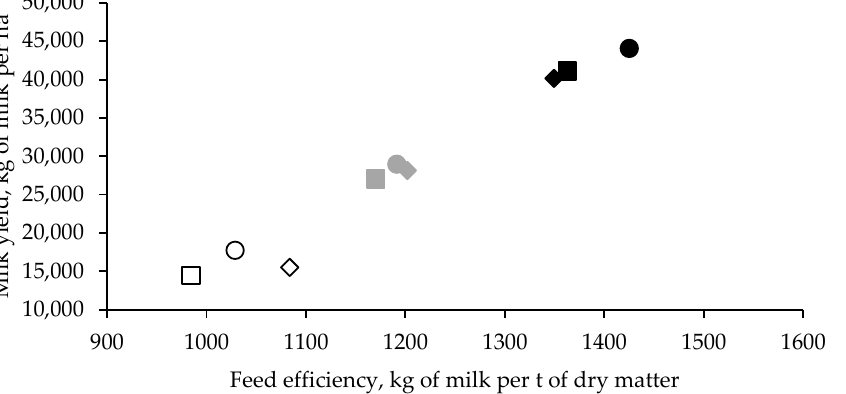
Figure 1. Estimation of milk production through Milk 2006 of the Maximus (●); Defender ( ■ ); and Feroz ( ♦ ) hybrids in three harvest stages: R4 (white); R5 (grey); and R6 (black).